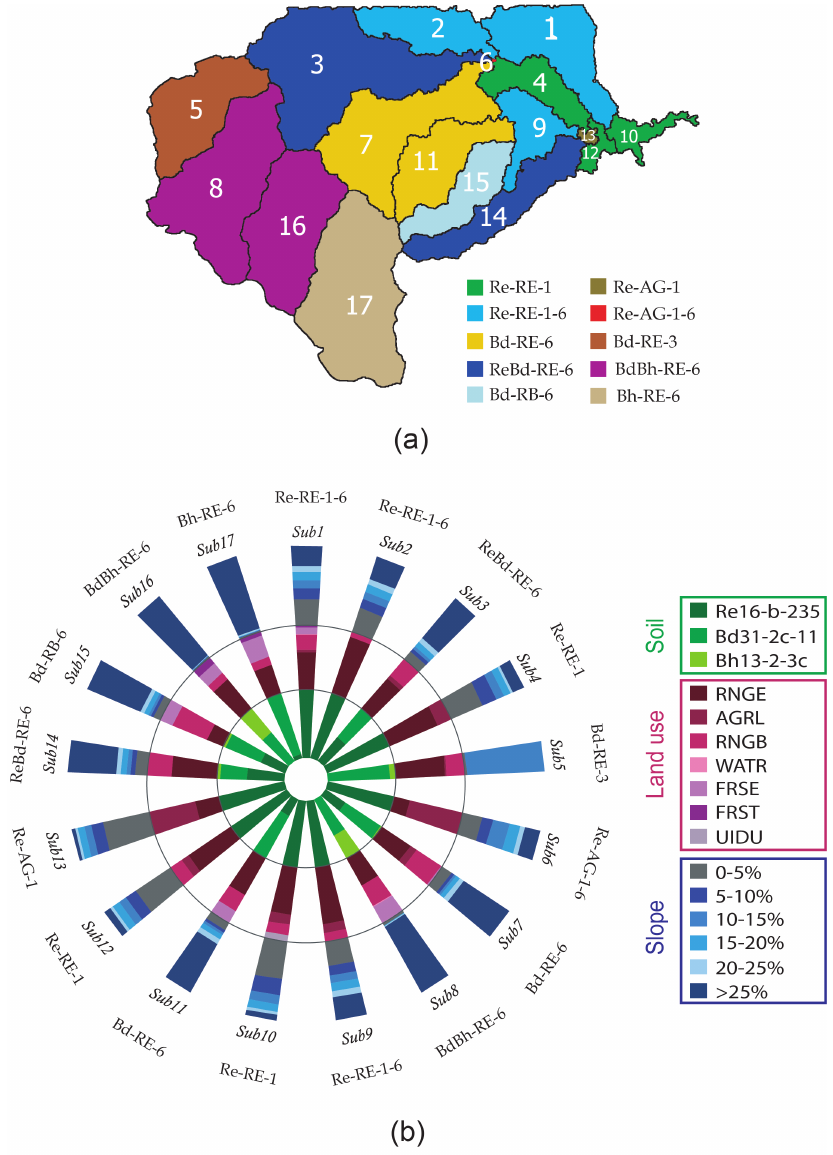
Figure 8. Clustering of the subbasins exhibiting similar features in terms of soil properties, land use, topographic slope, and precipitations ( a ). Panel ( b ) indicates the percentage of each soil group, land use category, and